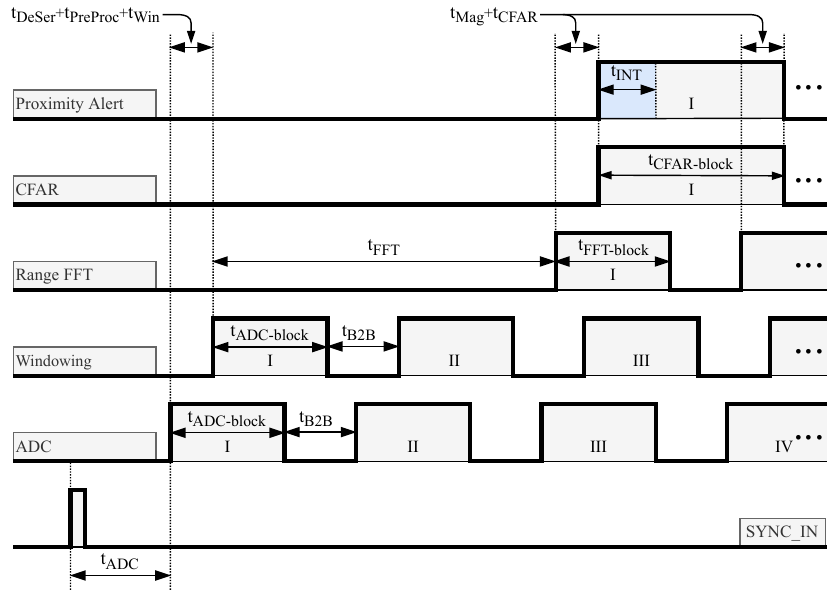
Figure 12. Illustration of the system latency when flushing is disabled.